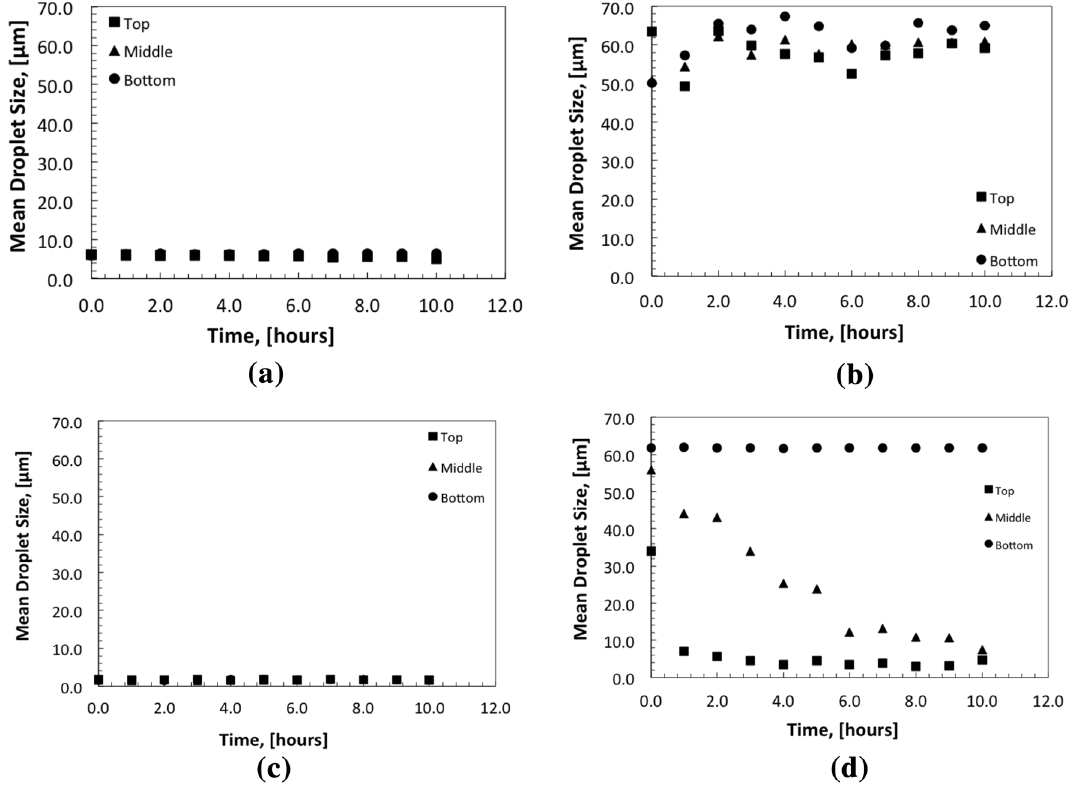
Fig. 11 Mean water droplet sizes for: a blank water-in-oil emulsion sample and water-in-oil emulsion with b AA-1, c AA-2 and d AA-3, respec-